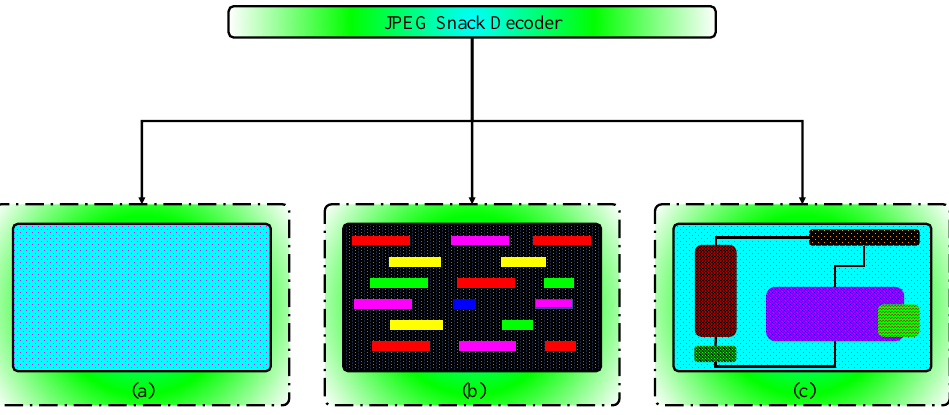
Figure 4. Components of JPEG Snack Decoder, ( a ) Default image ( b ) Timeline ( c ) Layer and position.